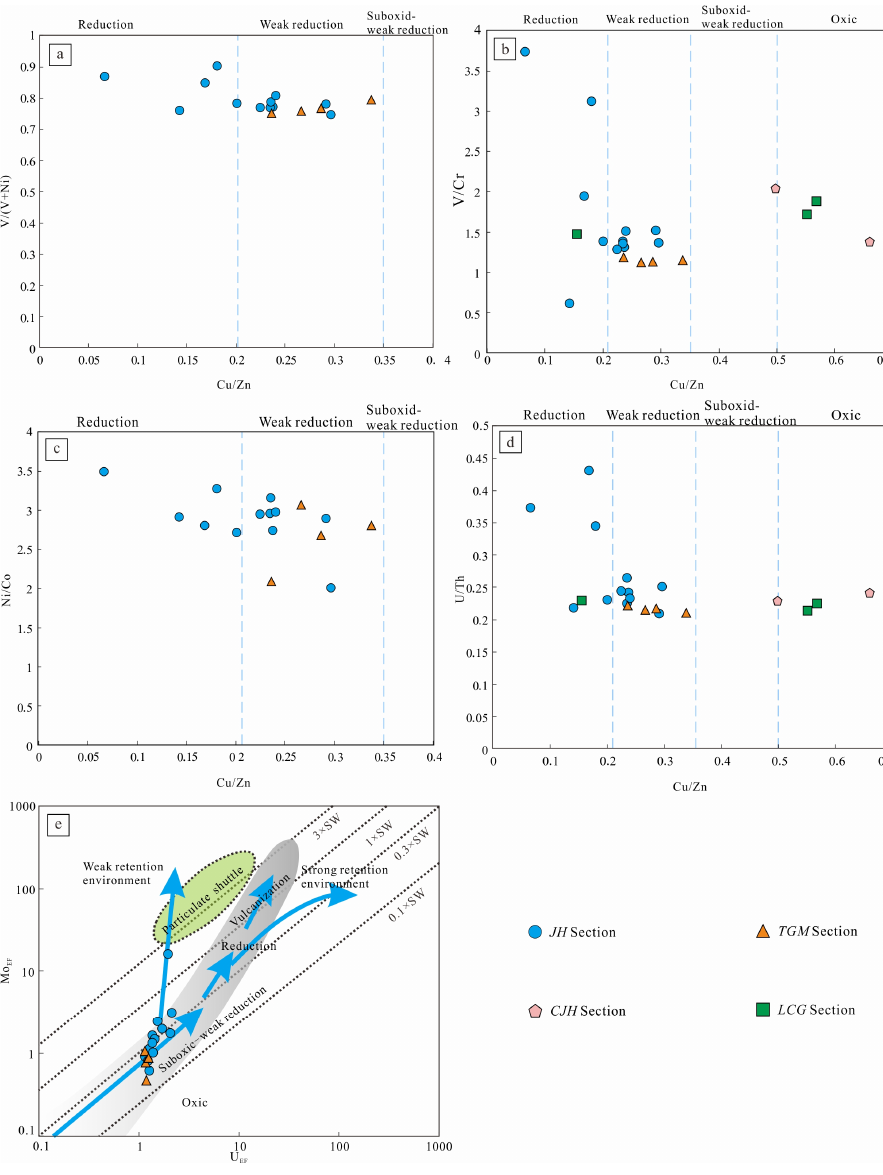
Figure 11. Discrimination map of the redox environment of each section in the Xu-3 Member (CJH and LCG data from [32]). ( a ) V/(V + Ni)-Cu/Zn; ( b ) V/Cr-Cu/Zn; ( c ) Ni/Co-Cu/Zn; ( d ) U/Th-Cu/Zn; ( e ) of the U EF − Mo EF (after [75,76]; revised). The molar concentration ratio of Mo/U in standard sea- water is represented by 1 × SW; 3 × SW, 0.3 × SW, and 0.1 × SW indicate Mo/U ratios 3 times, 0.3 times, and 0.1 times that of standard seawater, respectively. The grey area represents the U-Mo co- variant model in a normal open marine environment, and the green area represents the U-Mo co- variant model under the action of metal particle carriers.